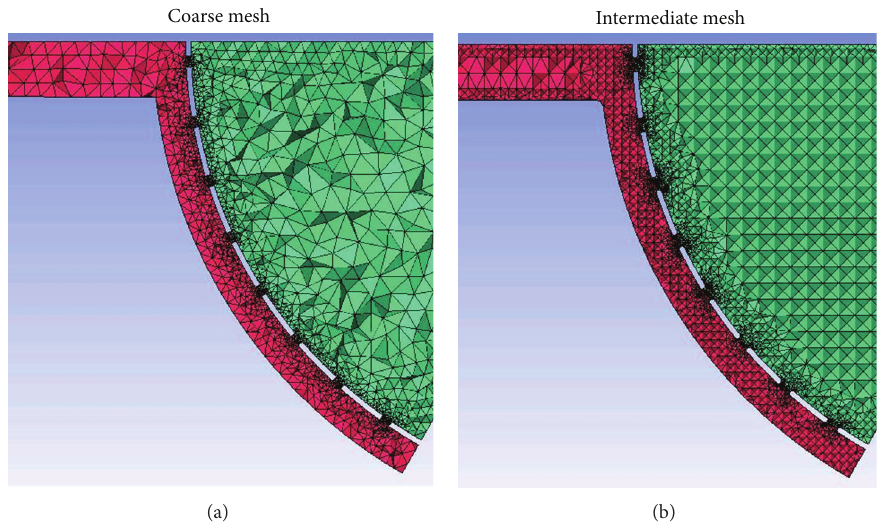
Figure 4: Coarse and intermediate meshing in a horizontal cut plan.